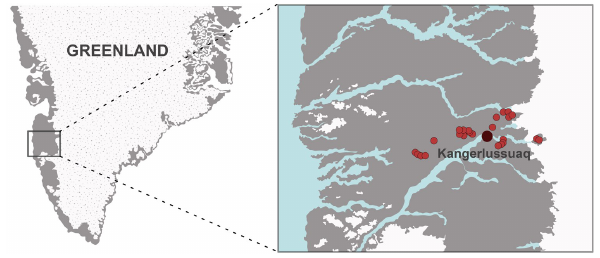
Figure 1. Map of study site, with the 24 study lakes surrounding Kangerlussuaq, Greenland, indicated by